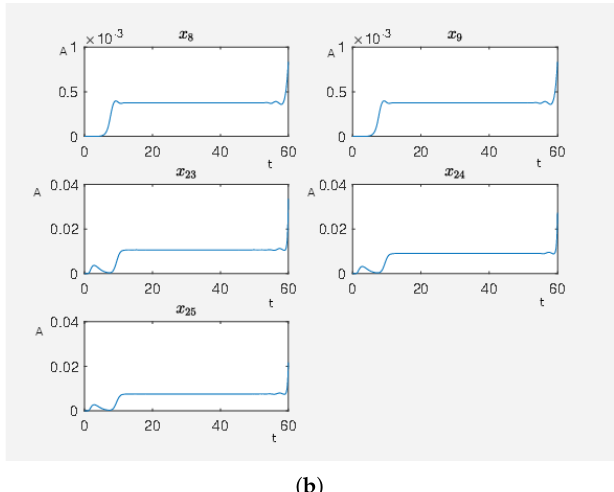
Figure 9. Blocking the constitutively activated G s -coupled β 1 receptor. ( a ) The external stimulus u 1 inhibits G s -coupled β 1 receptor. On the abscissa, we have the time (t) and on the ordinate the activity level (A). ( b ) Time curve of the nodes of interests where x 8 is the activity level of p90RSK, x 9 is the activity level of p70S6K, x 23 is the activity level of Elk1, x 24 is the activity level of MSK1 and x 25 is the activity level of c-Myc. On the abscissa, we have the time (t) and on the ordinate the activity level (A).